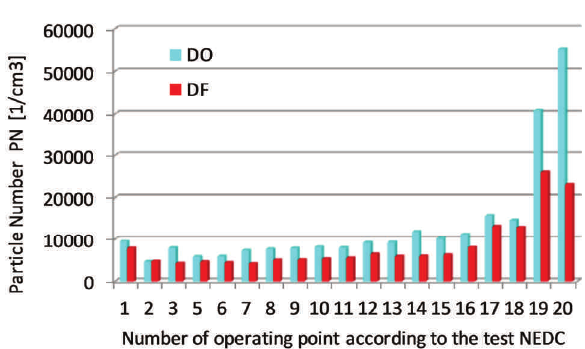
Fig. 4. Comparison of total PN number of particulate matter in exhaust gases of Fiat 1.3 MJT engine fueled traditionally and in dual fuel system: correction of air output, opening time of gas injectors 2.0